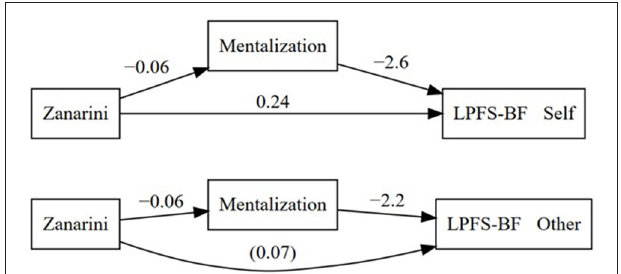
FIGURE 1 | Mediation models for the relationship between BPD severity and self- and other/interpersonal functioning as mediated by mentalizing abilities. The reported coefficients are obtained after controlling for the covariates gender and age.